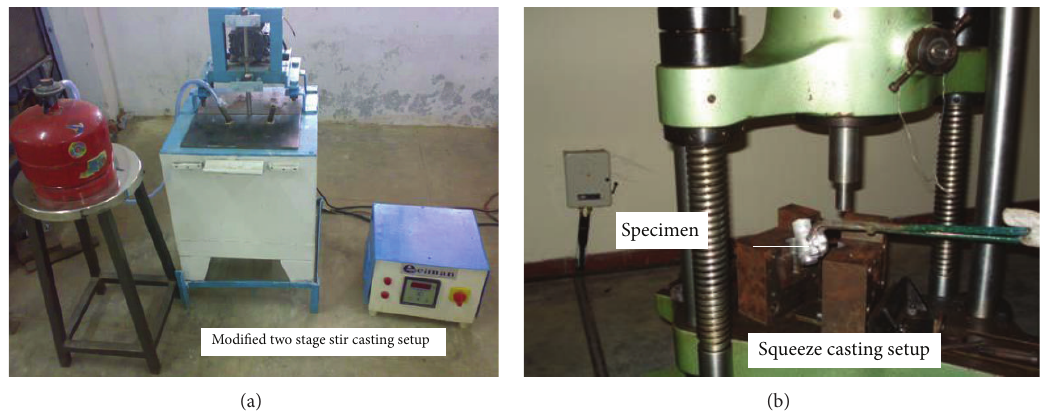
Figure 2: Modified two-stage stir casting (a) squeeze casting (b) setups.